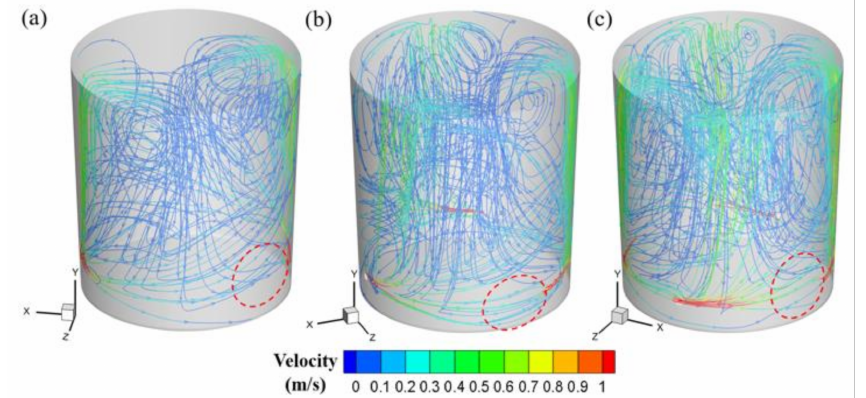
Figure 12. Streamlines with different numbers of side plugs at 116 mm: ( a ) dual plugs; ( b ) three plugs; ( c ) four side